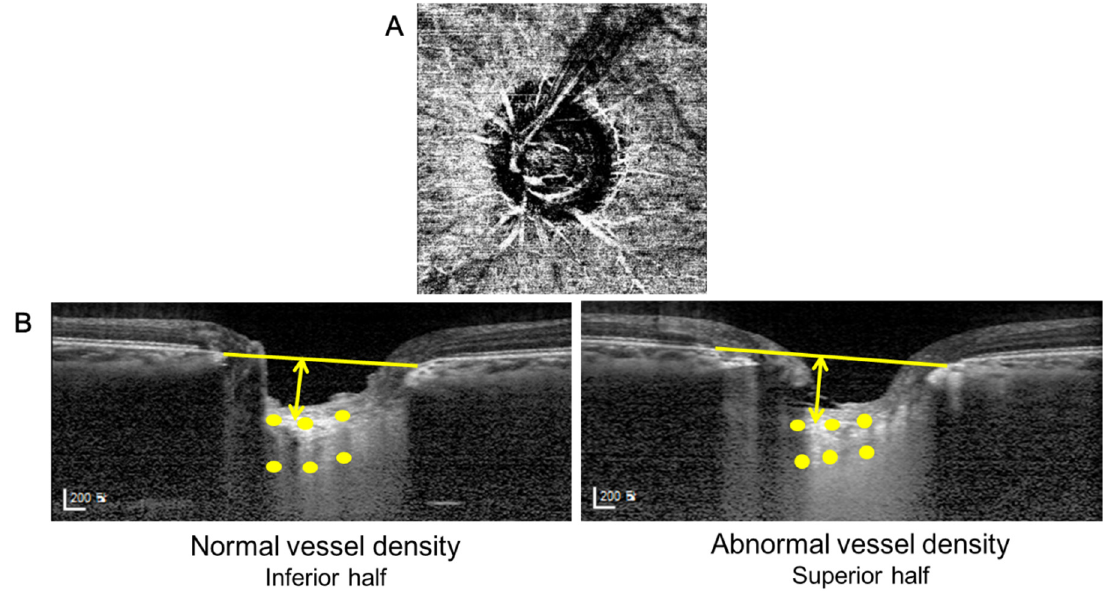
Figure 4. A representative case. ( A ) A 47-year old man with deep VD defect in his superotemporal peripapillary area of left eye. ( B ) The lamina cribrosa of his superior half was thinner and more deeply located than that of his inferior half.